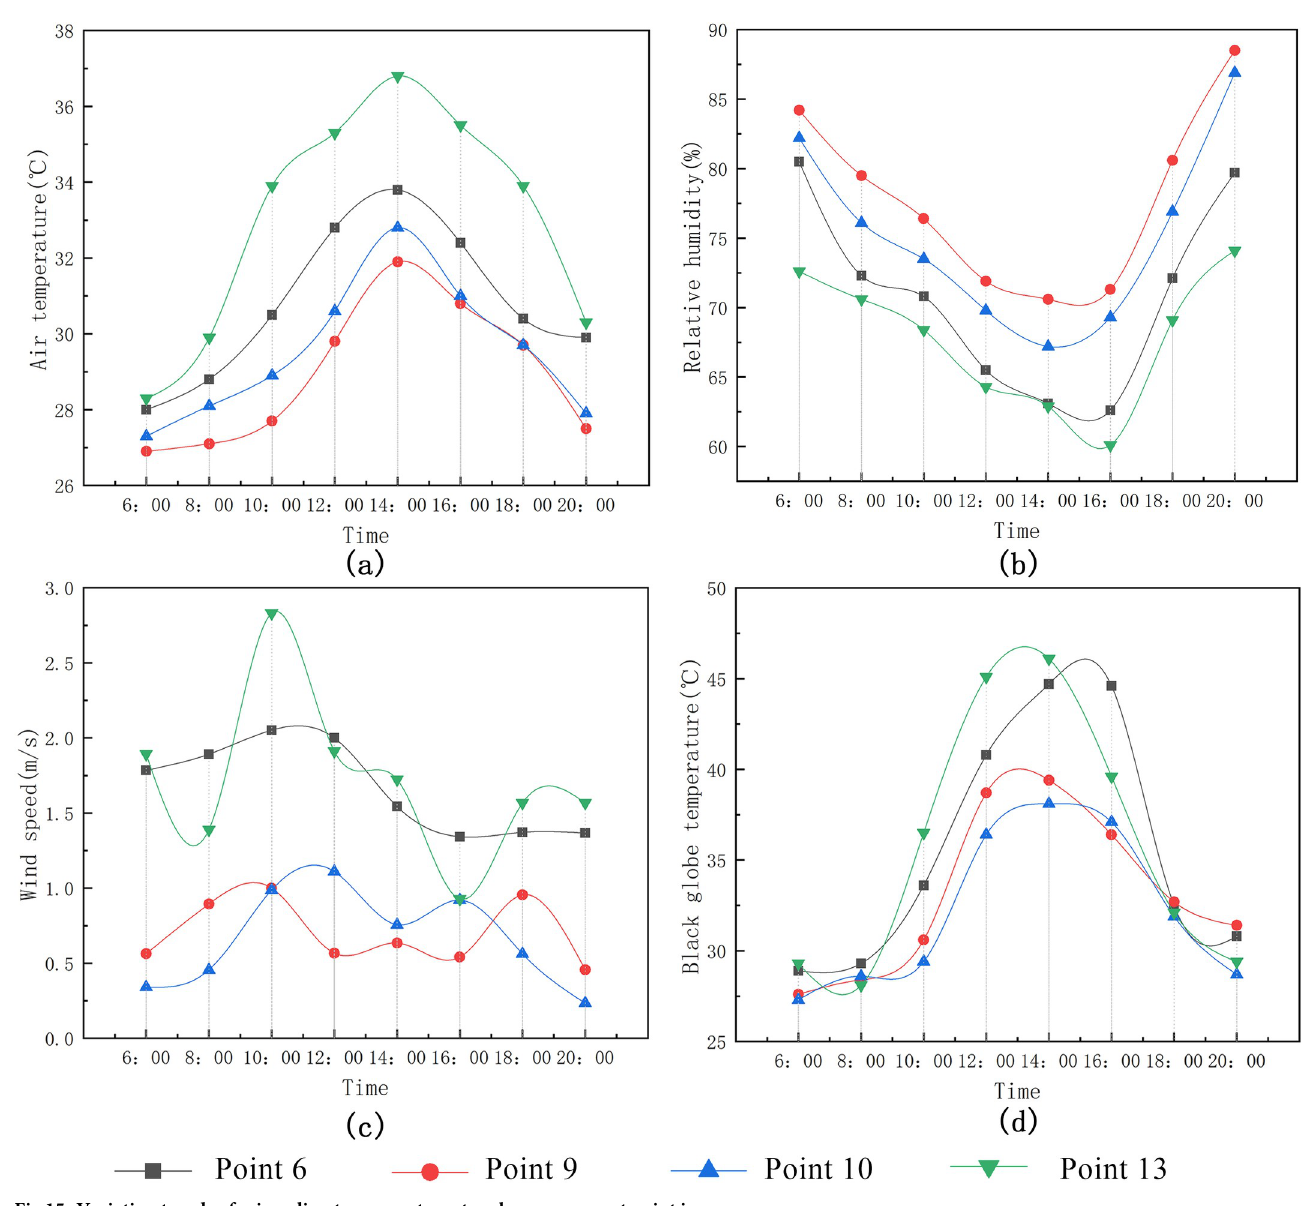
Fig 15. Variation trends of microclimate parameters at each measurement point in green